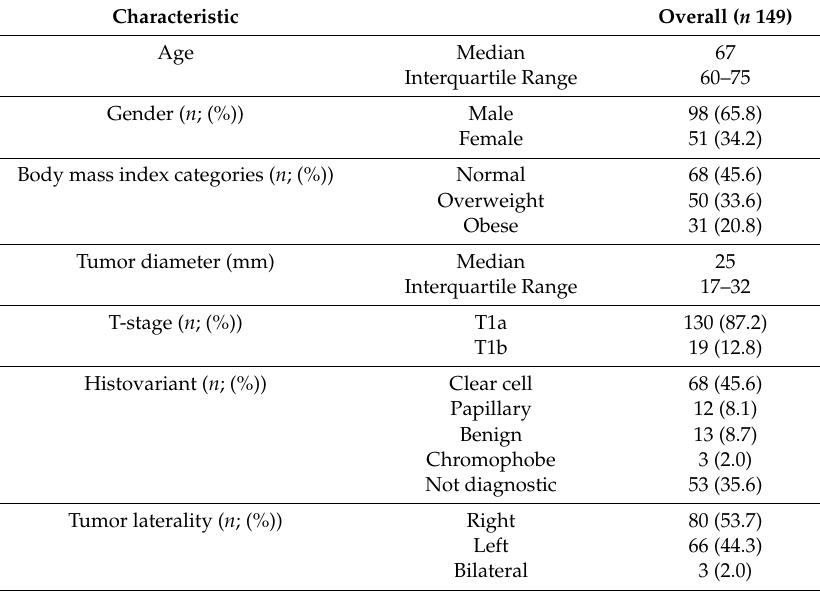
Table 1. Descriptive characteristics of 149 patients with non-metastatic T1a-b renal tumor treated with RFA from 2004 to